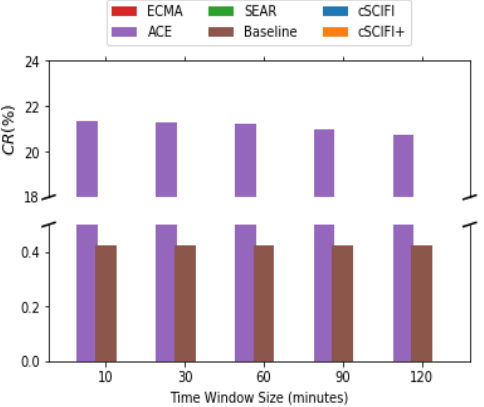
Figure 4. Coverage loss for different time window sizes.